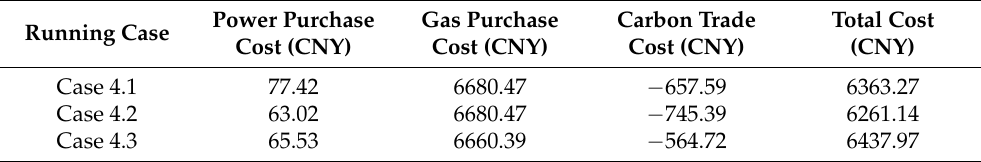
Table 4. The different cost between Case